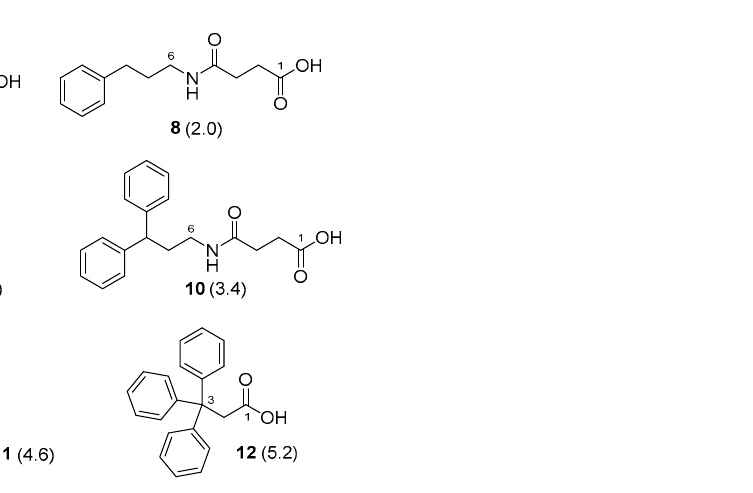
Figure 4. Structures of aromatic head groups 7 – 12 with cLogP values of the corresponding methyl ester in parentheses.